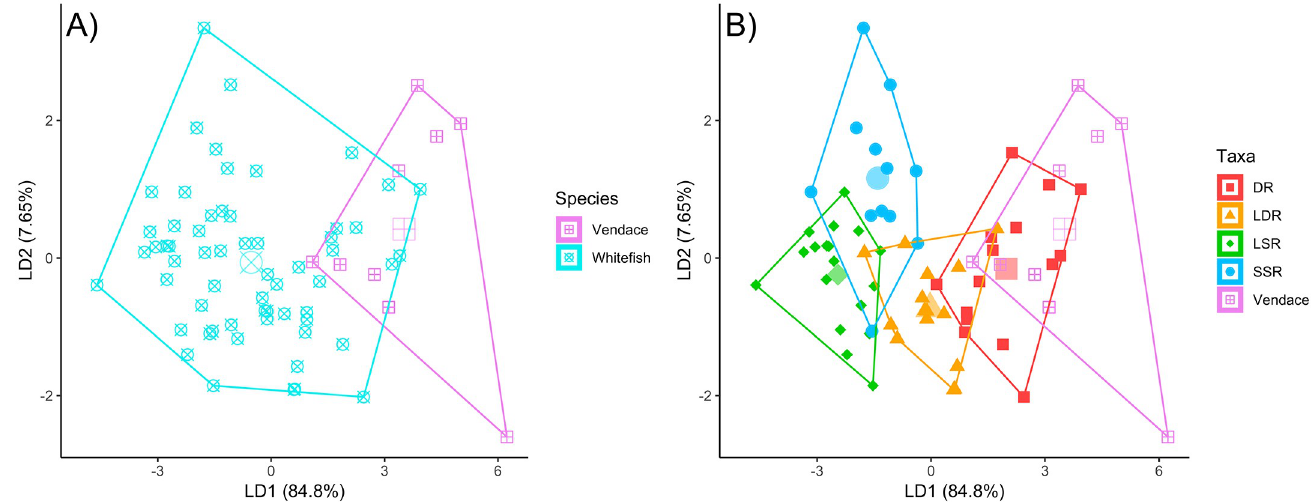
Fig 2. Plots of the first two LDA axes for all coregonid taxa. Hulls indicate grouping; left-hand plot (A) shows species-level differences between whitefish and vendace; right-hand plot (B) show differences among whitefish morphs. Larger translucent points represent group centroids. Percentage of total variance explained by each axis is included in brackets. DR = densely rakered whitefish, LDR = large densely rakered whitefish, LSR = large sparsely rakered whitefish, SSR = small sparsely rakered whitefish.